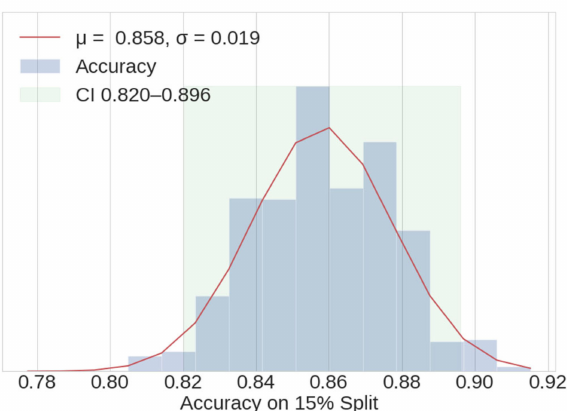
Figure 10. Histogram of accuracy for 1500 random splits of a 15% portion of the entire dataset. Using the selected NN model, ROC curves were generated from the entire dataset, test dataset and holdout data, and they are presented in Figure 11. The selected specificity and sensitivity of (0.79/0.86) were selected by matching the 0.79 specificity of the prior work [8]. This pair is denoted by the blue star, and occurs at a classification threshold of 0.651.